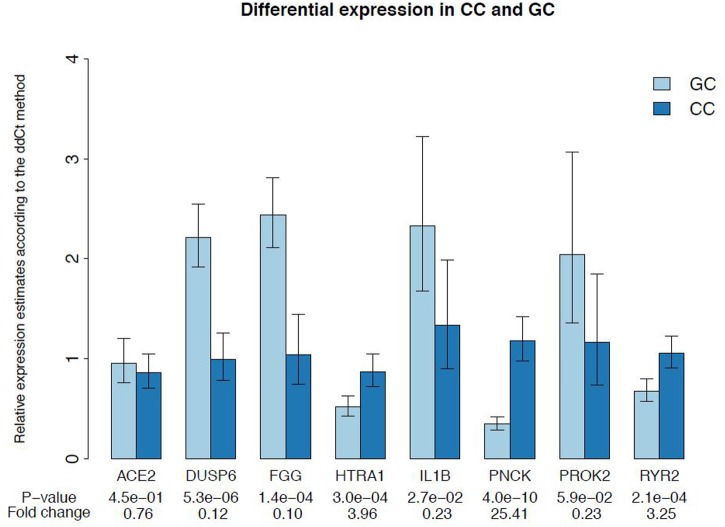
qPCR validation of microarray data.The results represent mean relative mRNA expression of the selected genes ± SEM.